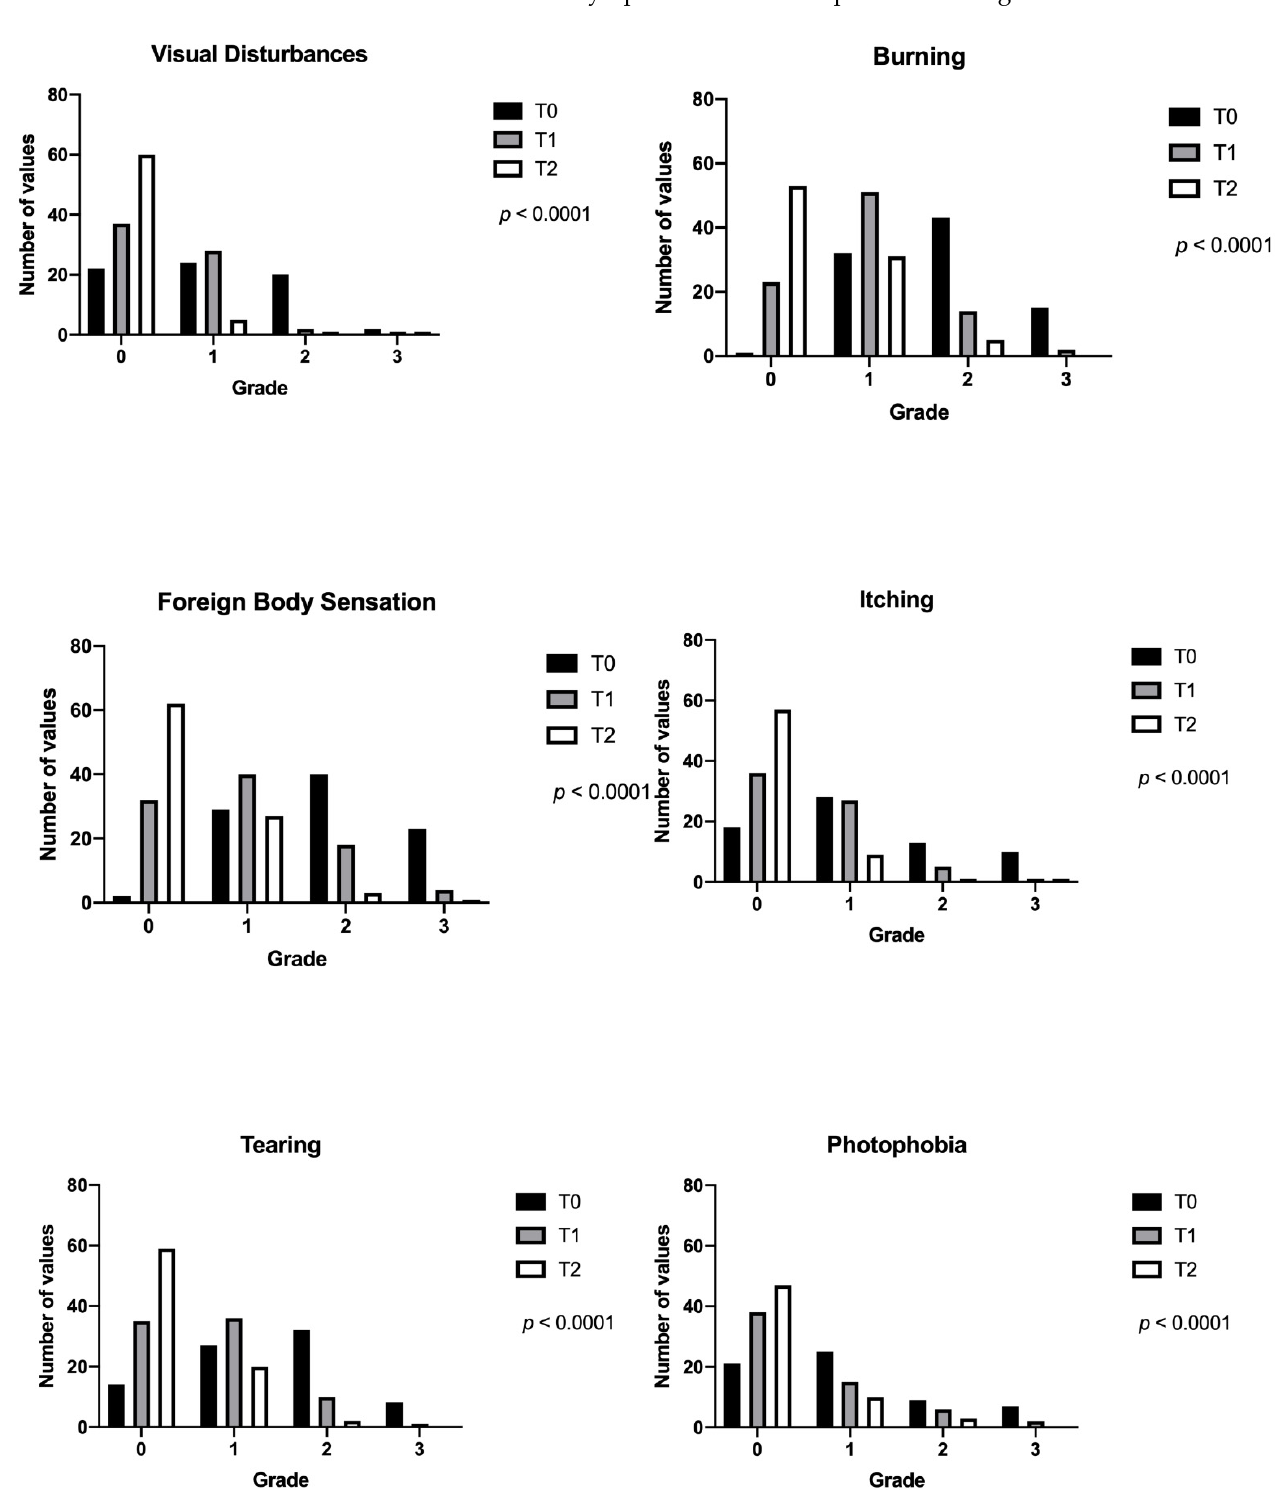
Figure 3. Evolution of the intensity of the several US symptoms at different time frames (ANOVA p < 0.0001).